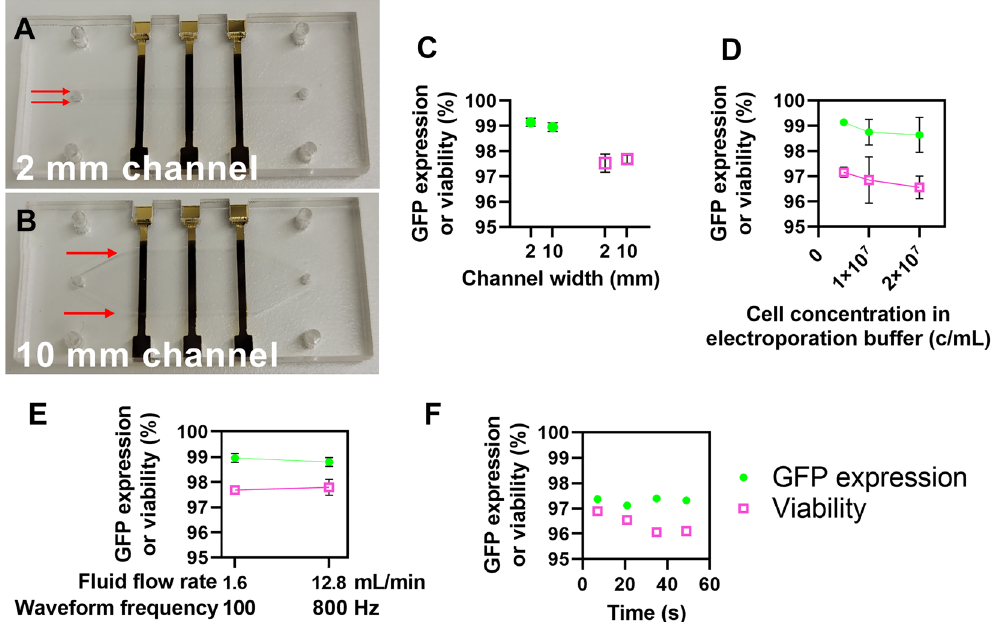
Figure 4. Increasing cell processing throughput for clinical-scale volumes. ( A ) Photograph of a 2 mm and ( B ) 10 mm electroporation flow cell. Red arrows highlight the channel width. ( C ) Plot of GFP expression and viability values from Jurkat cells transfected with mRNA encoding GFP in either the 2- or 10-mm channels ( n = 3). ( D ) Plot of GFP expression and viability values from Jurkat cells transfected with mRNA encoding GFP in the 2-mm channel at varying cell concentrations in the electroporation buffer ( n = 3). ( E ) Plot of GFP expression and viability values from Jurkat cells transfected with mRNA encoding GFP in the 10-mm channel at varying flow rates and waveform frequencies ( n = 3). ( F ) Plot of GFP expression and viability over time from an experiment that transfected ~ 240 million cells over 56 s ( n = 1). Data shown as mean ± standard deviation ( C – E ). Some error bars are too small to be visible ( C – E